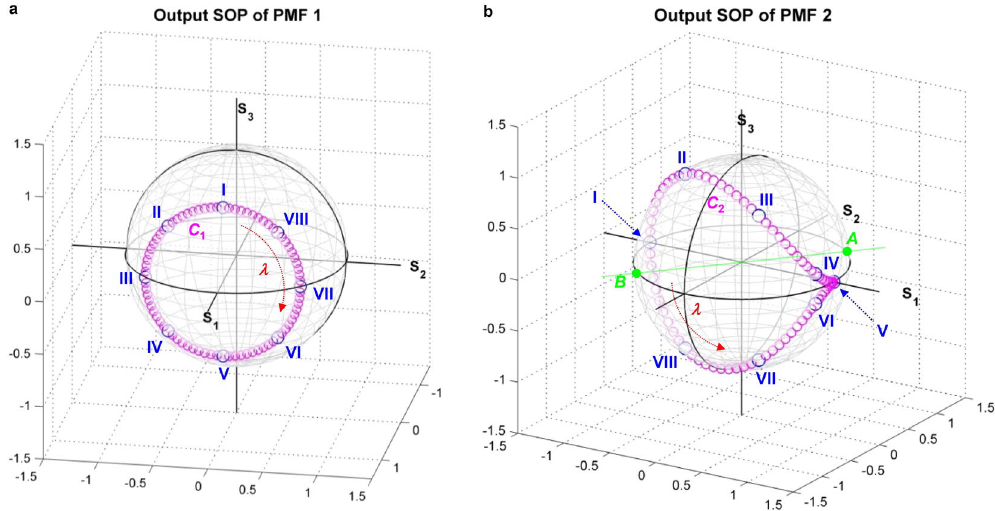
Figure 5. ( a ) Spectral evolution of SOP out of PMF 1 within FSR Δ λ s in CW path for Sets I–VIII in Table 1 at = 0°. As indicated by a red arrow, the SOP θ p 1 out traces out a circle C 1 on the Poincare sphere as the wavelength increases from λ A to λ B , moving CW around the S 1 axis. ( b ) Spectral evolution of SOP out of PMF 2 within FSR Δ λ s in CW path for Sets I–VIII in Table 1. Similarly, as indicated by a red arrow, the SOP out makes one CW rotation around the S 2 axis along the trajectory C 2 of a droplet shape with increasing